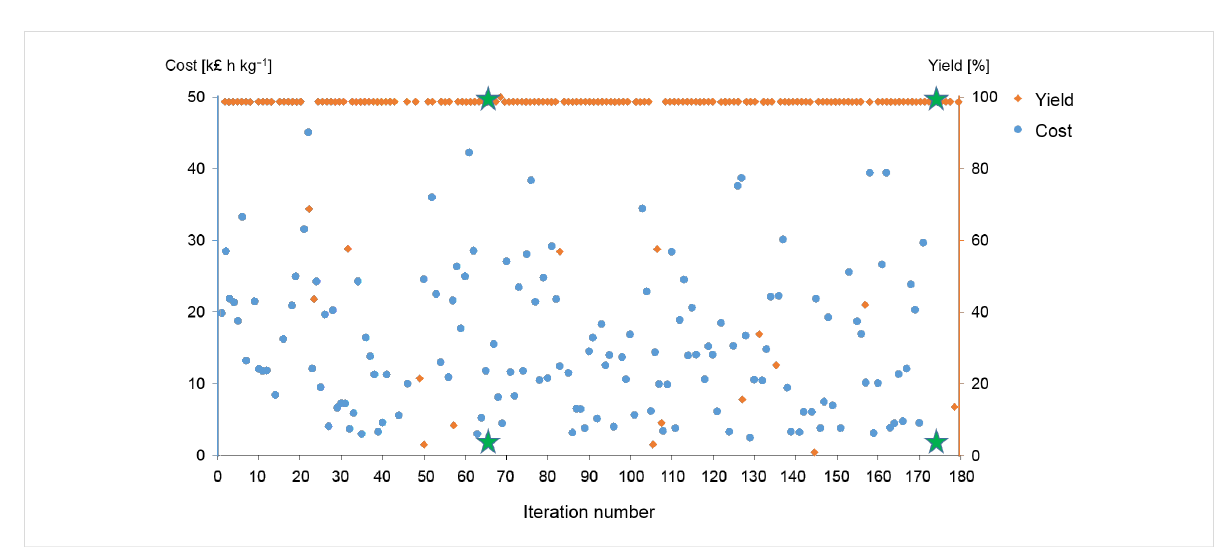
Figure 4: Results of in silico iterations of the multi-objective active learner (MOAL) algorithm [26]. Each iteration produces two resulting values, one for yield and one for the cost function. Targets were 100% for yield and 2,108 k£ h kg − 1 for the cost function. Green stars signify experiments that satisfy the selected